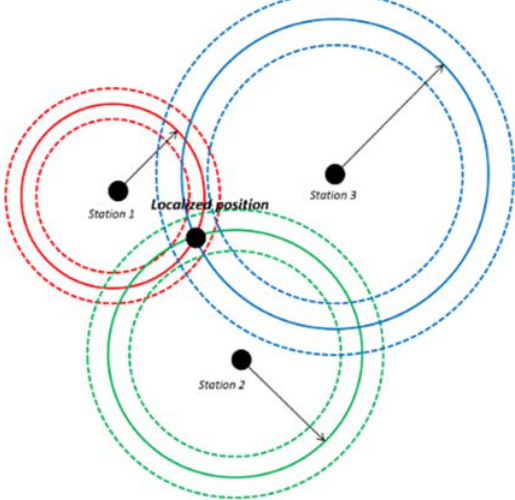
Figure 1. The principle of circular lateration with three stations